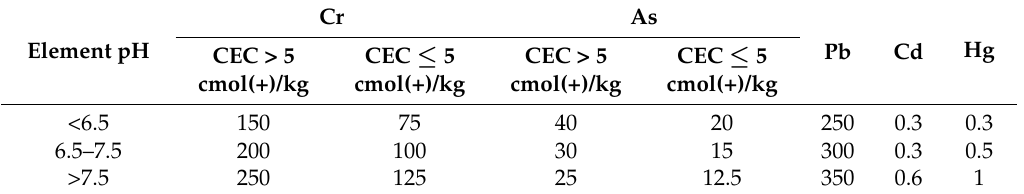
Table 1. Grade II values of GB15618-1995 (unit: mg/kg).